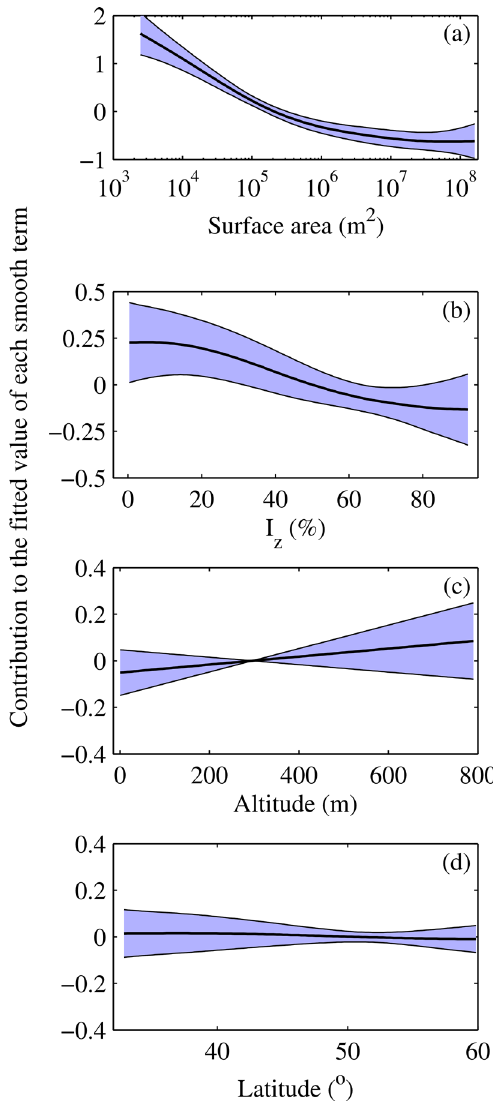
Fig 2. Fitted splines for the Generalised Additive Model. The y-axis is the additive contribution of the spline to the fitted model over the range of the covariate. The smooth functions are subject to centring constraints and are plotted here on different scales for clarity. The shaded region is an approximate 95% confidence interval on the function; however, it excludes uncertainty in the model's constant term, β 0 , hence the narrowness of the interval at the “ middle ” of the distribution for the smooths of altitude and